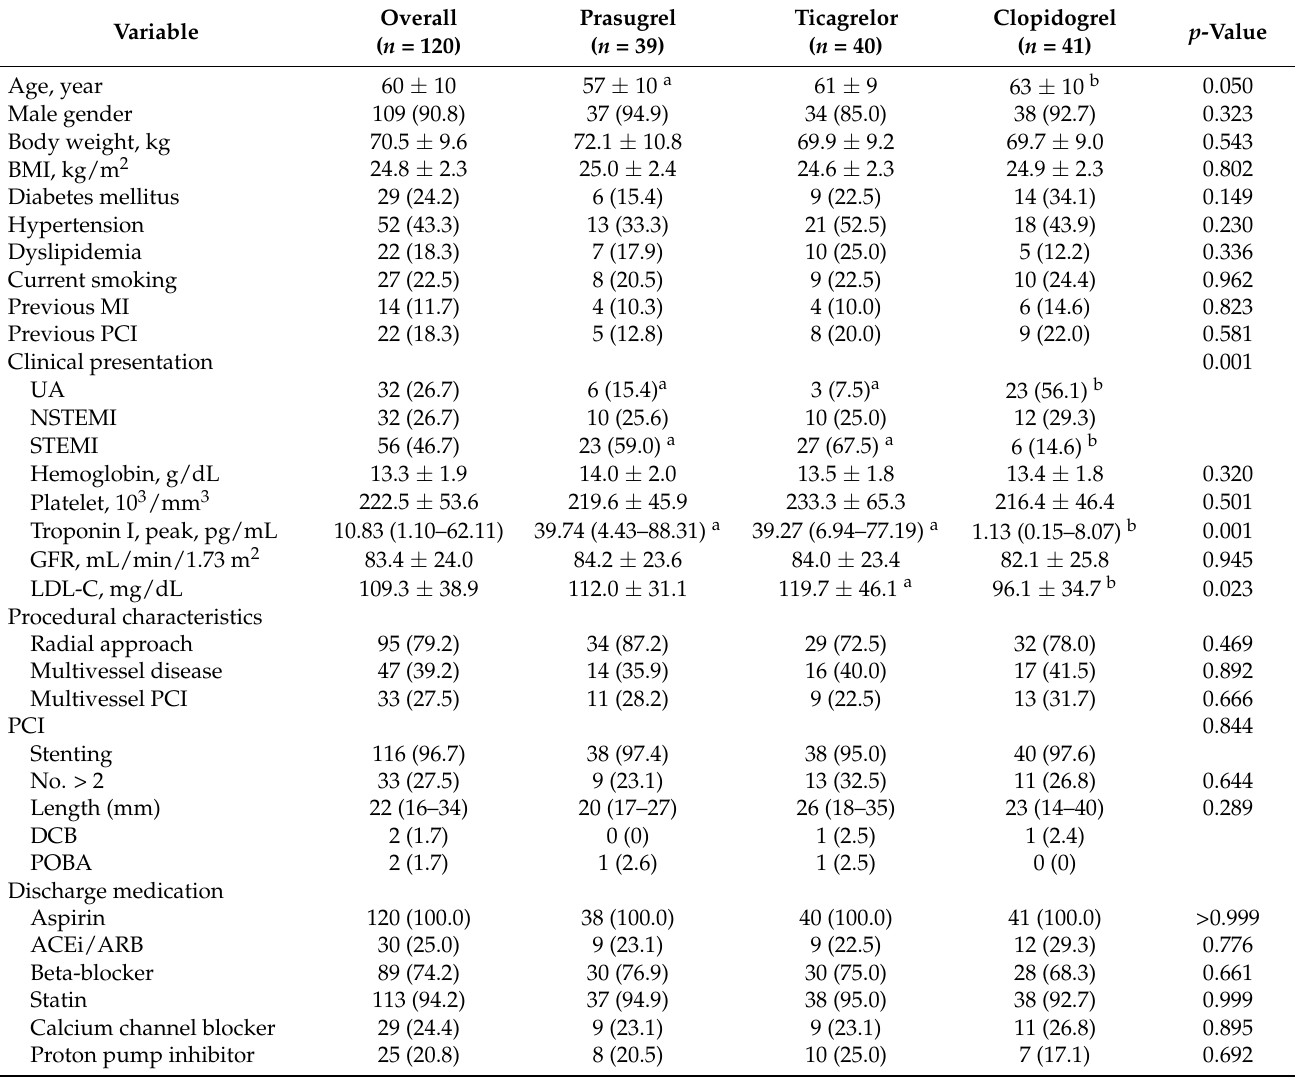
Table 1. Baseline